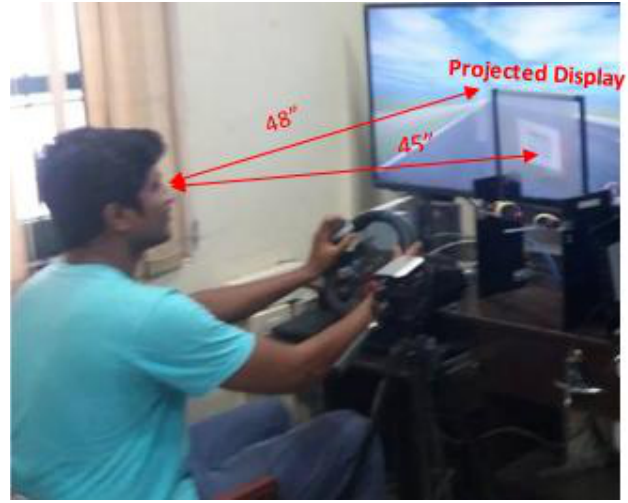
Figure 25. Set up of gaze controlled projects display.